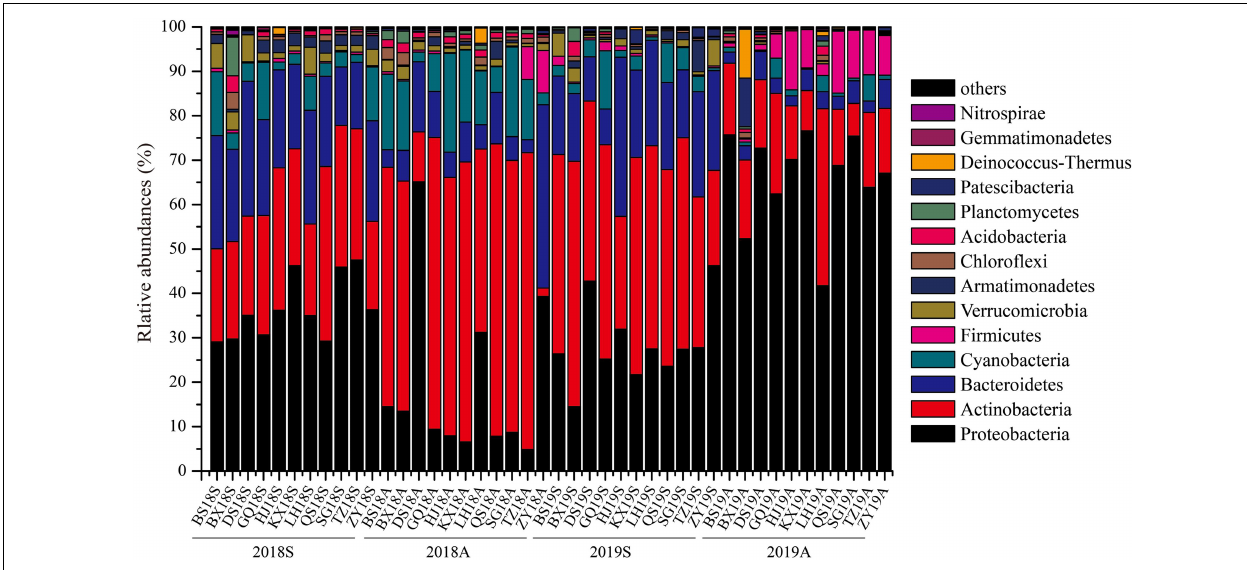
FIGURE 2 | Relative abundance of bacterioplankton sequences at the phylum.